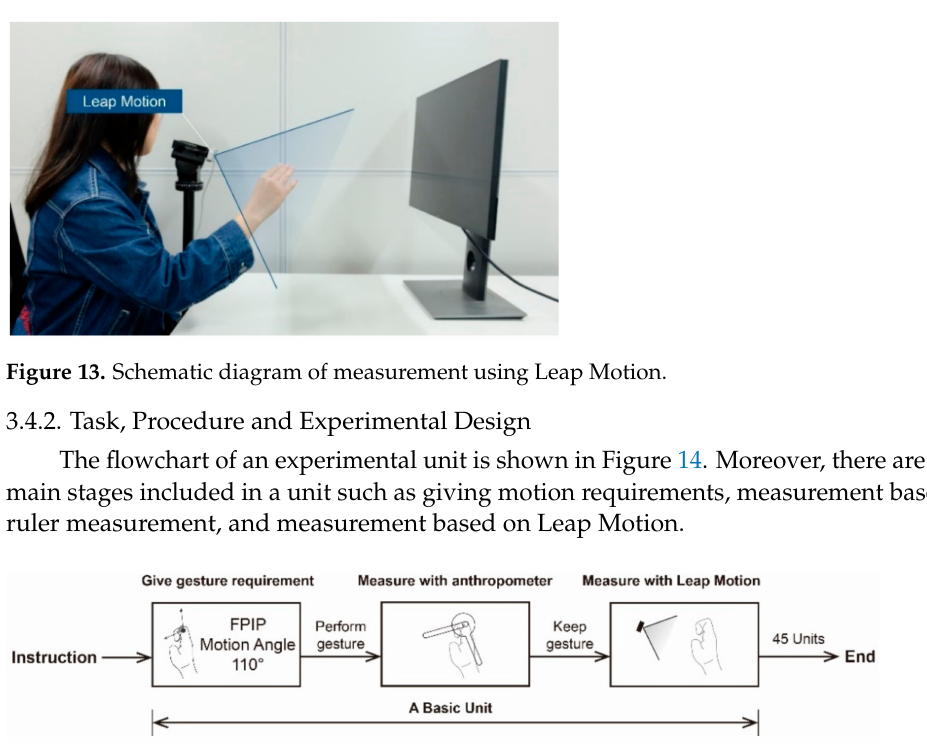
Figure 14. Experimental flowchart of practical experiment on state division of motion primitive units based on Leap Motion.